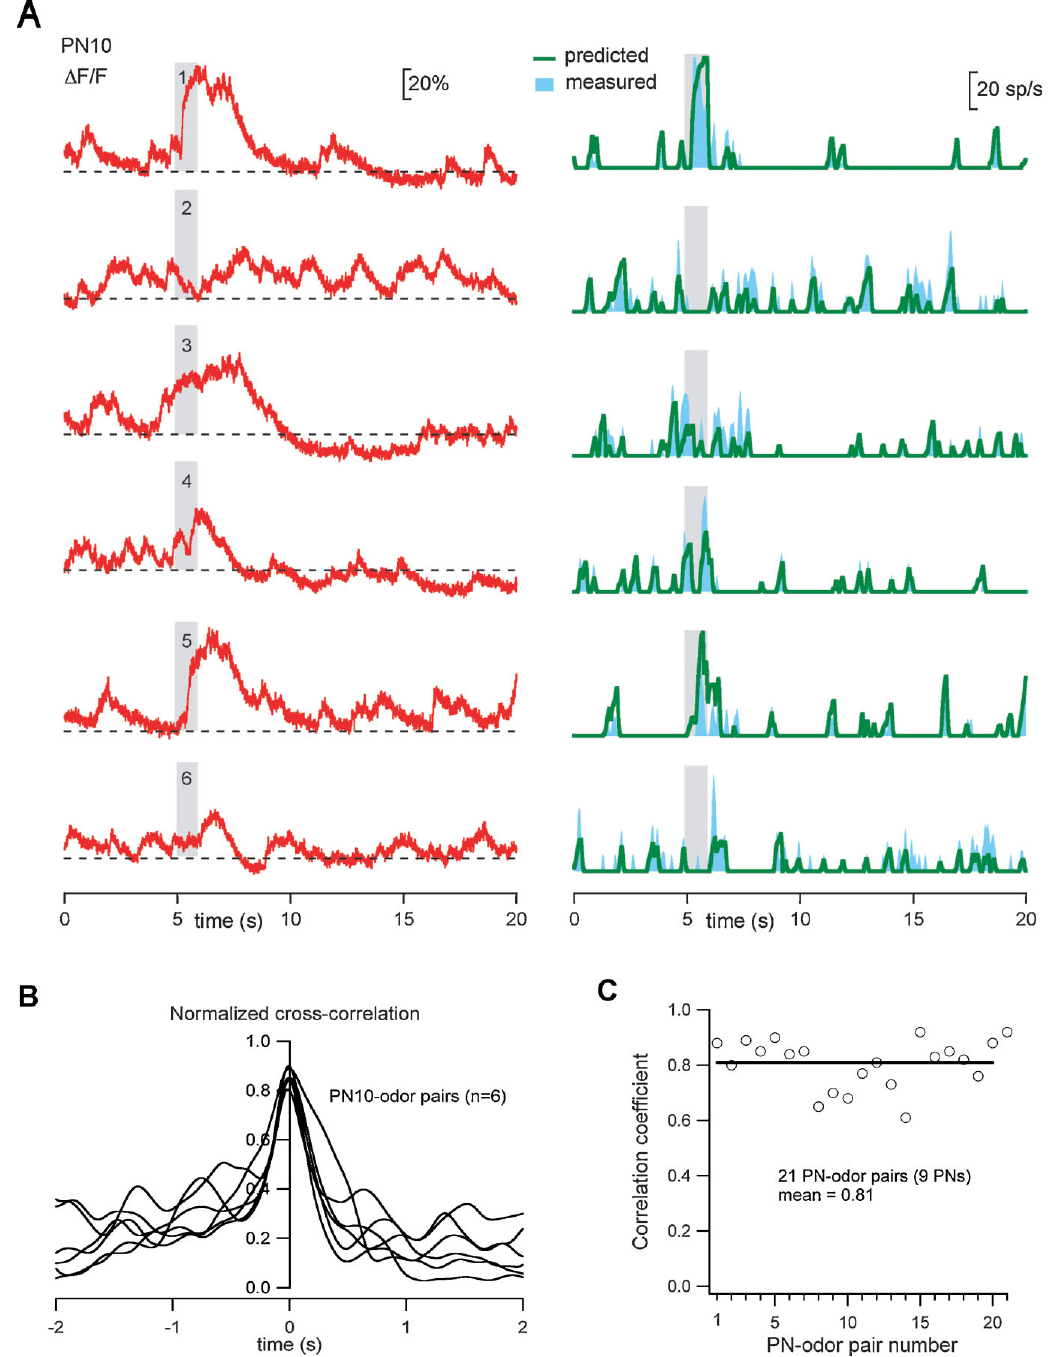
Figure9. Reliabilityoffiring-ratepredictionovervariousstimuliandresponsepatterns .( A )Comparisonofpredicted(green)andmeasured(cyan)smoothed firing rates. All plots are from single-trials, with the same PN (PN10), and six odors (1: cis-3-hexen-1-ol, 50%; 2:1-hexanol, 50%; 3: benzaldehyde, 50%; 4: benzaldehyde,0.5%;5:isoamylacetate,50%;6:isoamylacetate,0.5%).Correspondingrawfluorescencetraces(red)arejuxtaposed,toemphasizethedifference between calcium signals and spike discharge. ( B ) Normalized cross-correlations between predicted and measured (50ms-Gaussian smoothing) rates for the six trials in A . Peak correlations are between 0.80 and 0.90. ( C ) Measure of peak cross-correlation (at dt = 0, as in B ) for 21PN-odor pairs calculated with 9PNs. These correlations are calculated over the entire duration of each trial, and thus represent both stimulus-evoked and spontaneous activity, as shown in A . In all cases, the only trial-specific parameter is FB (minimum fluorescence during pre-stimulus baseline); all other parameters are fixed and identical (see text).